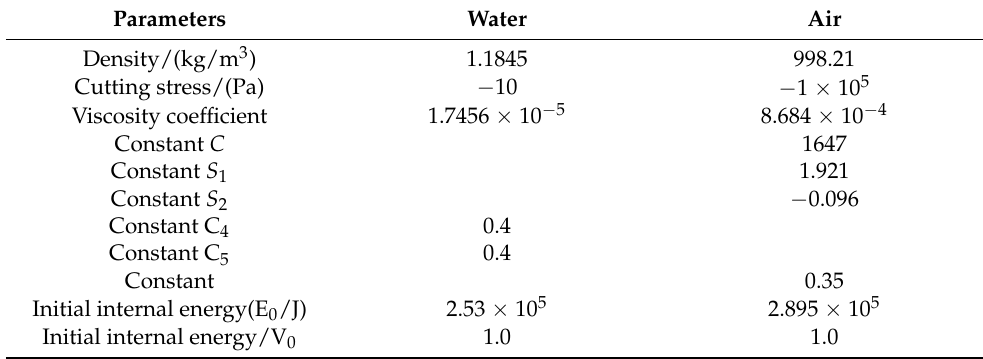
Table 3. Water and air material model